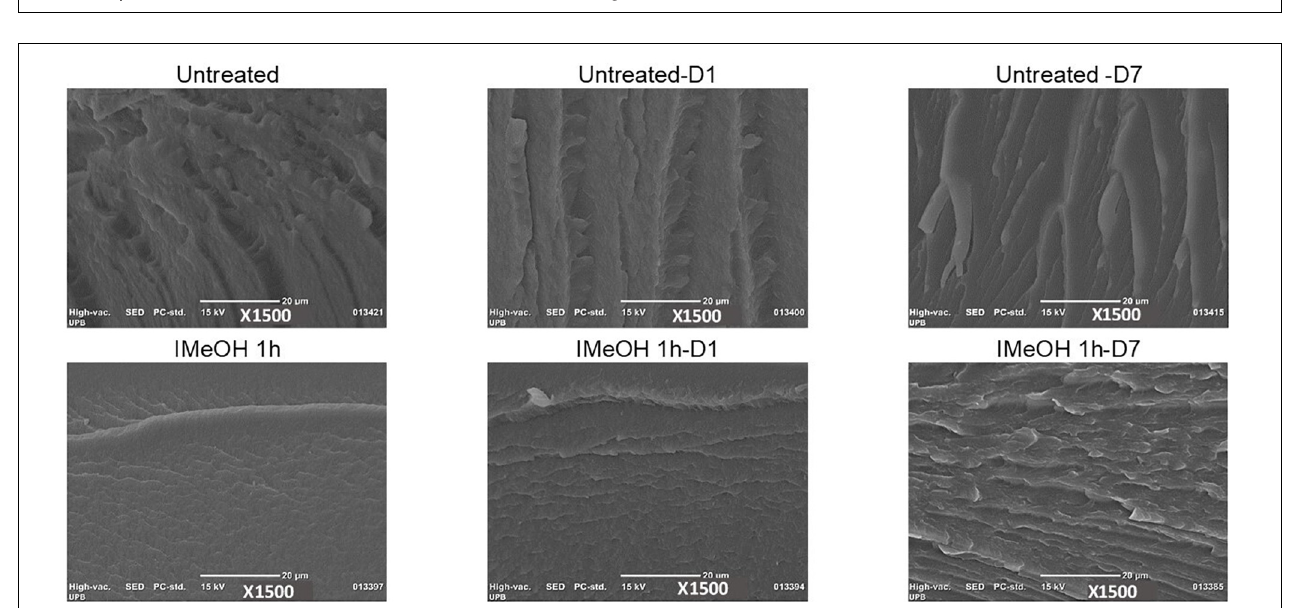
FIGURE 6 | SEM untreated, treated films IMeOH 1 h, before and after the degradation.